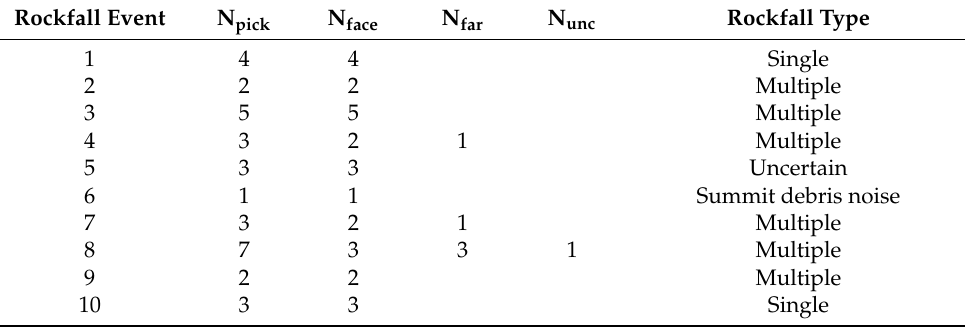
Table 1. Summary of the location results for 10 rockfall events. “N pick ” refers to the number of signals that can be picked from all the five geophones in each rockfall event. “N face ” refers to the number of signals that were located on or near the rock face. “N far ” refers to the number of signals that were located on the boundary of the model and far from the rock face. “N unc ” refers to the number of signals that were unexpectedly located in the middle of the model rather than on the rock face so that the localization result is considered uncertain. “Rockfall type” is explained in the